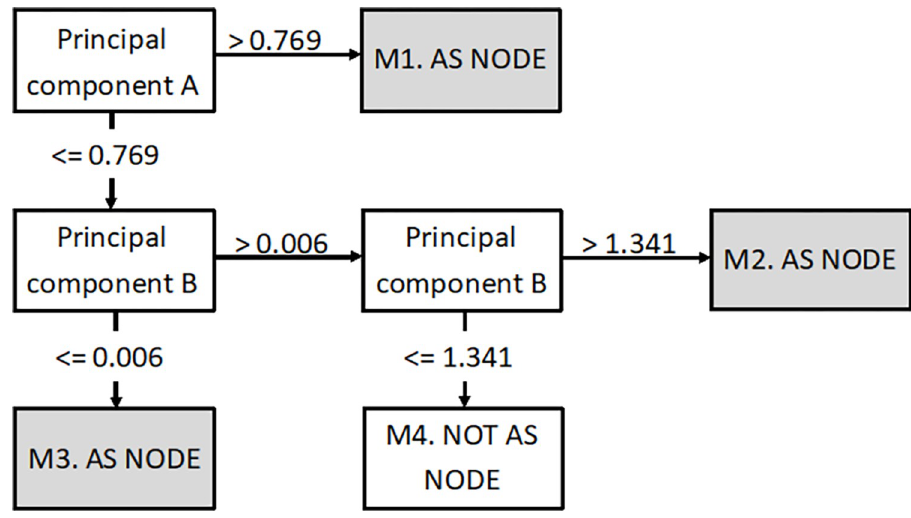
Fig 2. Combined results of machine learning (male).